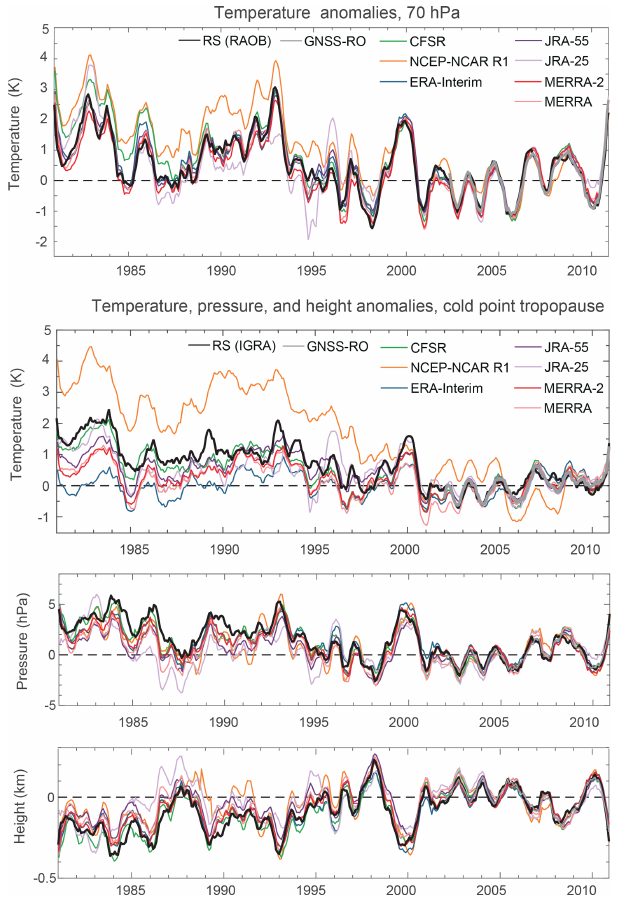
Figure 9. Time series of deseasonalized anomalies in 70hPa tem- perature (upper), cold point temperature (upper middle), cold point pressure (lower middle), and cold point altitude (lower) averaged over the tropics (20 ◦ S–20 ◦ N) and evaluated relative to the refer- ence period 2002–2010. Time series are shown for reanalysis prod- ucts, radiosonde data (RAOBCORE and IGRA), and radio occul- tation data (GNSS-RO). Time series are smoothed with a 7-month running mean.